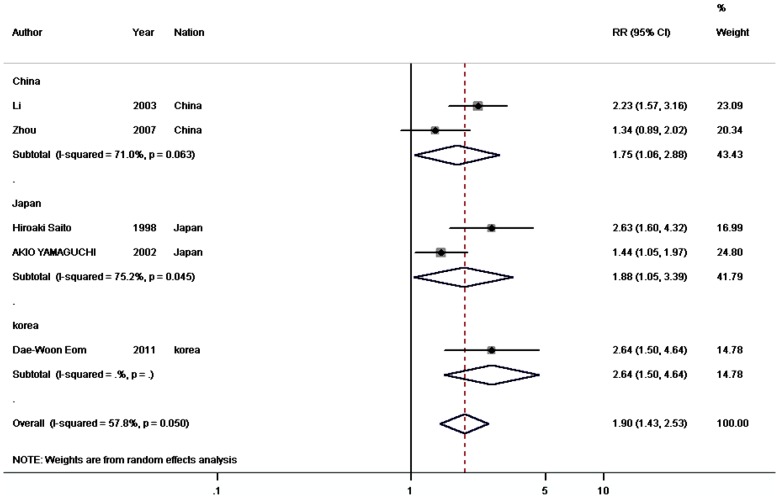
Meta-analysis on the relation between CD44v6 expression and 5-year overall survival (OS).The summary RR and 95% CIs were shown (random-effect model analysis).